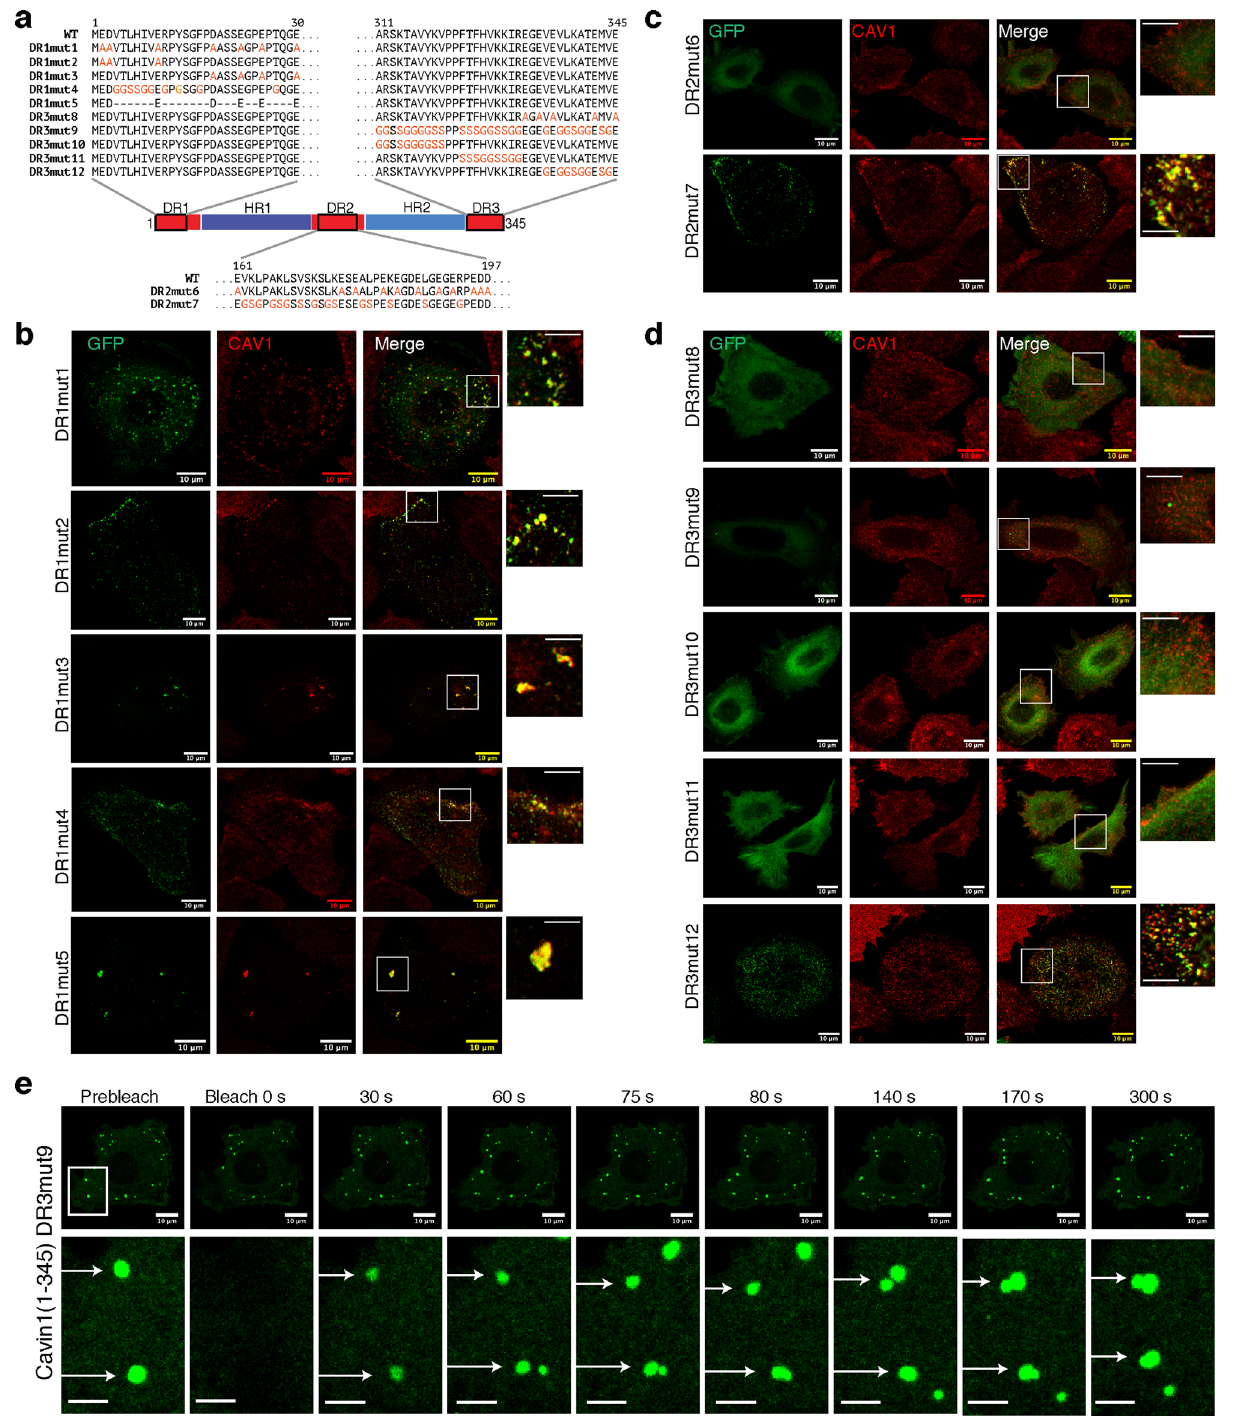
Fig. 8 Sequence requirements of the Cavin1 DR domains in caveola assembly. a Schematic diagram of Cavin1(1 – 345) with the sequences of the various point mutants indicated. DR1, DR2 and DR3 mutations occur in the regions 1 – 30, 161 – 197 and 311 – 345 respectively. b GFP-tagged Cavin1(1 – 345) DR1 domain mutants (green), c DR2 domain mutants and d DR3 domain mutants expressed in PC3 cells and immunolabelled with endogenous CAV1 (red). Images in b – d were by Airyscan confocal microscopy. Scale bar = 10 µ m; enlarged boxes scale bar = 5 μ m. e FRAP analysis of Cavin1 (1 – 345) DR3mut9 mutant showing fast recovery of fl uorescence in cytosolic droplets and also droplet fusion events (marked by arrow). Scale bar = 10 µ m; enlarged boxes scale bar = 5 μ